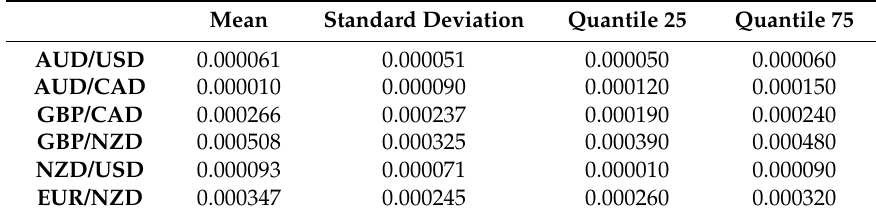
Table 6. The mean and standard deviation of the bid-ask spread of the selected currency pairs during the trading period (1 January 2017 to 31 December